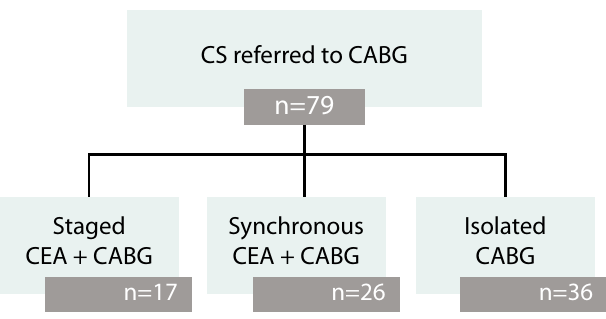
Fig. 2 - Enrollment and treatment assignment. CABG=coronary artery bypass grafting; CEA=carotid endarterectomy; CS=carotid